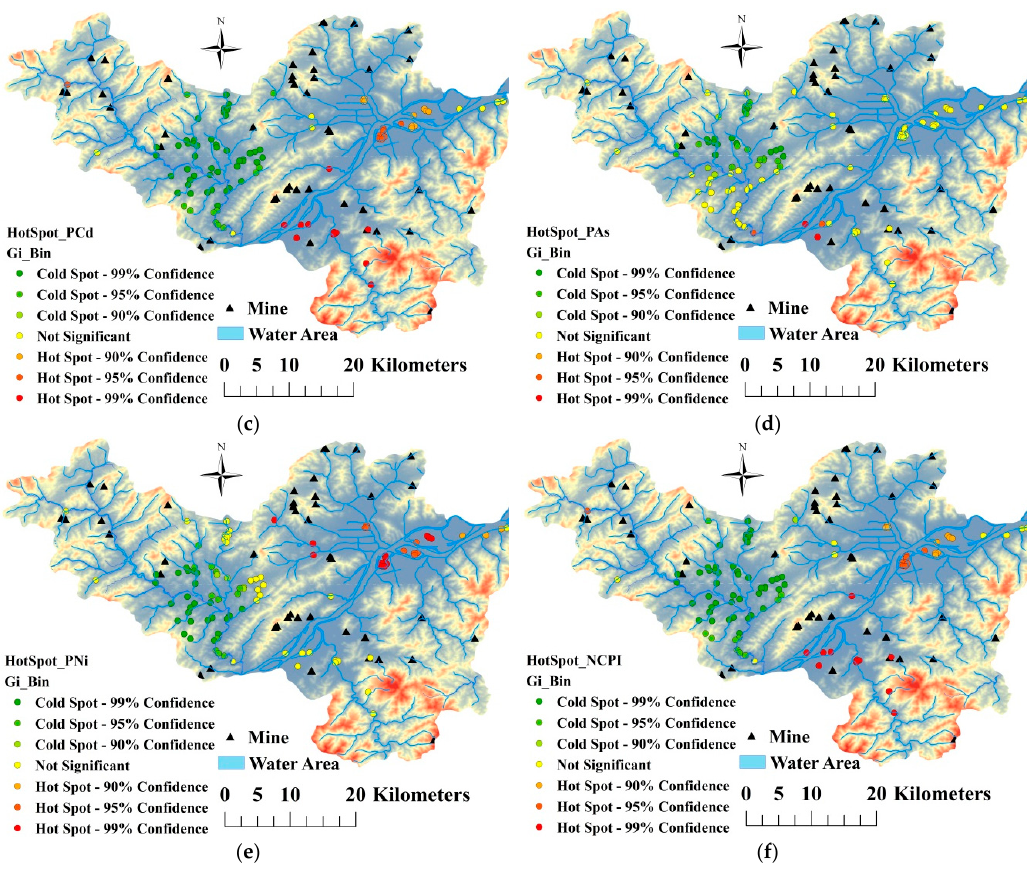
Figure 4. Hotspots of individual pollution indexes for Cr ( a ), Pb ( b ), Cd ( c ), As ( d ), Ni ( e ) and Nemerow composite pollution index ( f ).